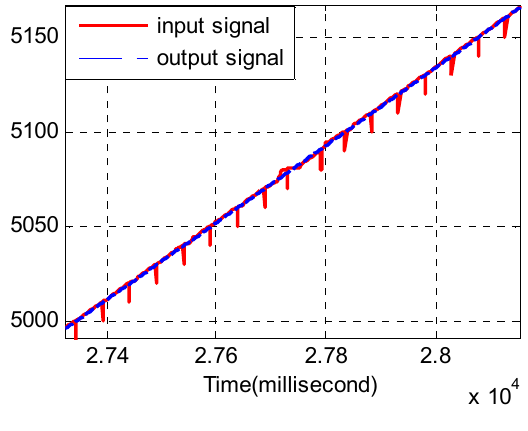
Figure 14. Comparison of the input signal and the output signal.